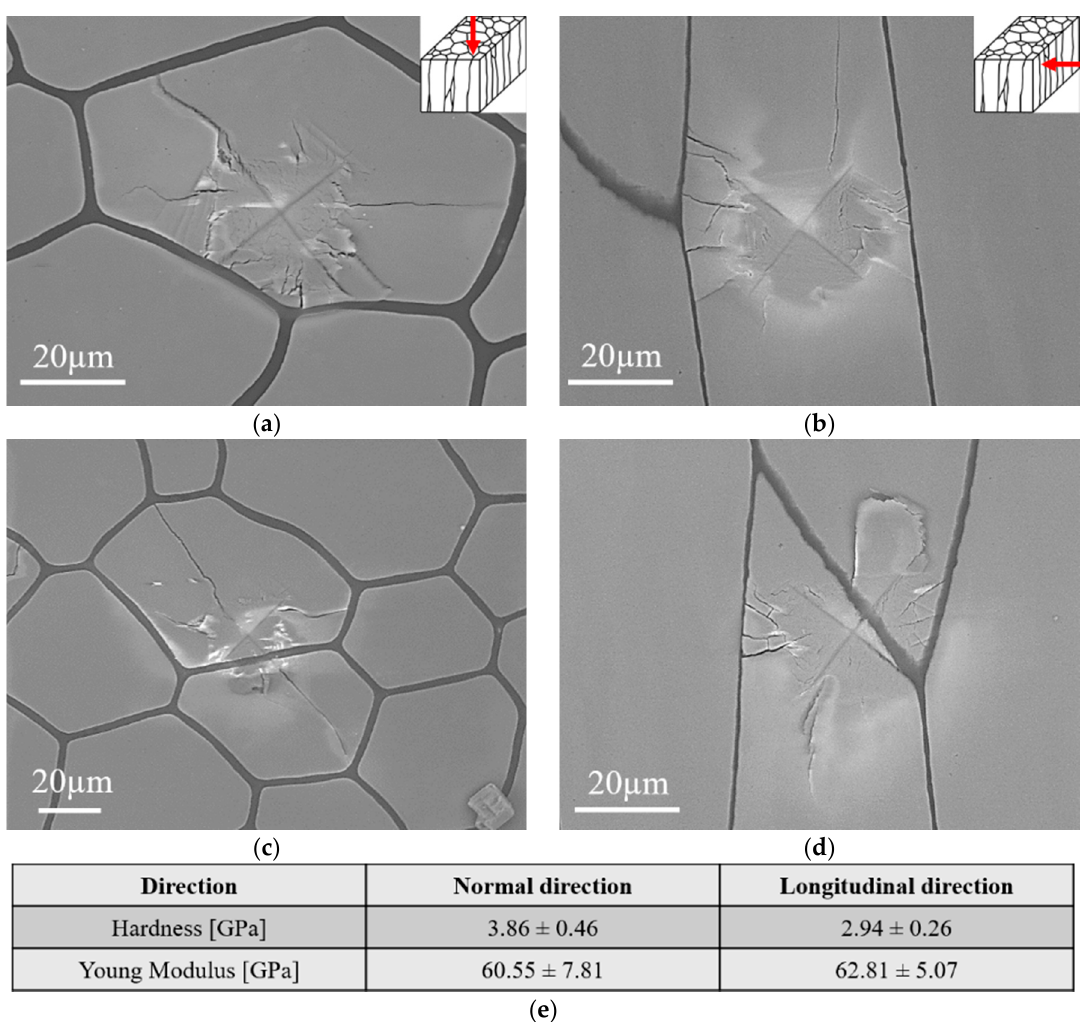
Figure 5. SEM/BSE microstructure images presenting the indents acquired from the section perpendicular to ND ( a , c ) and LD ( b , d ) and the measured with nanoindentation values of hardness and Young modulus for each direction ( e ).